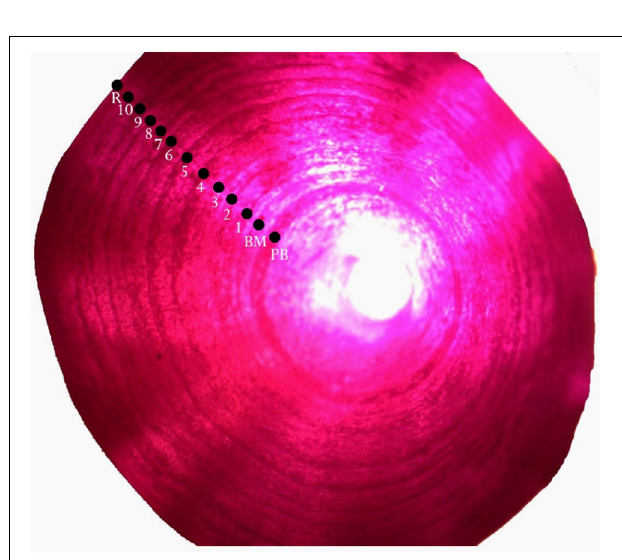
FIGURE 4 | A whole vertebral centrum of a male P. kamoharai (91 cm FL) stained with Alizarin Red S showing growth band pairs; PM: Pre-Birth mark; BM: birthmark, R: centrum radius. Vertebral centrum observed through a microscope using transmitted light.